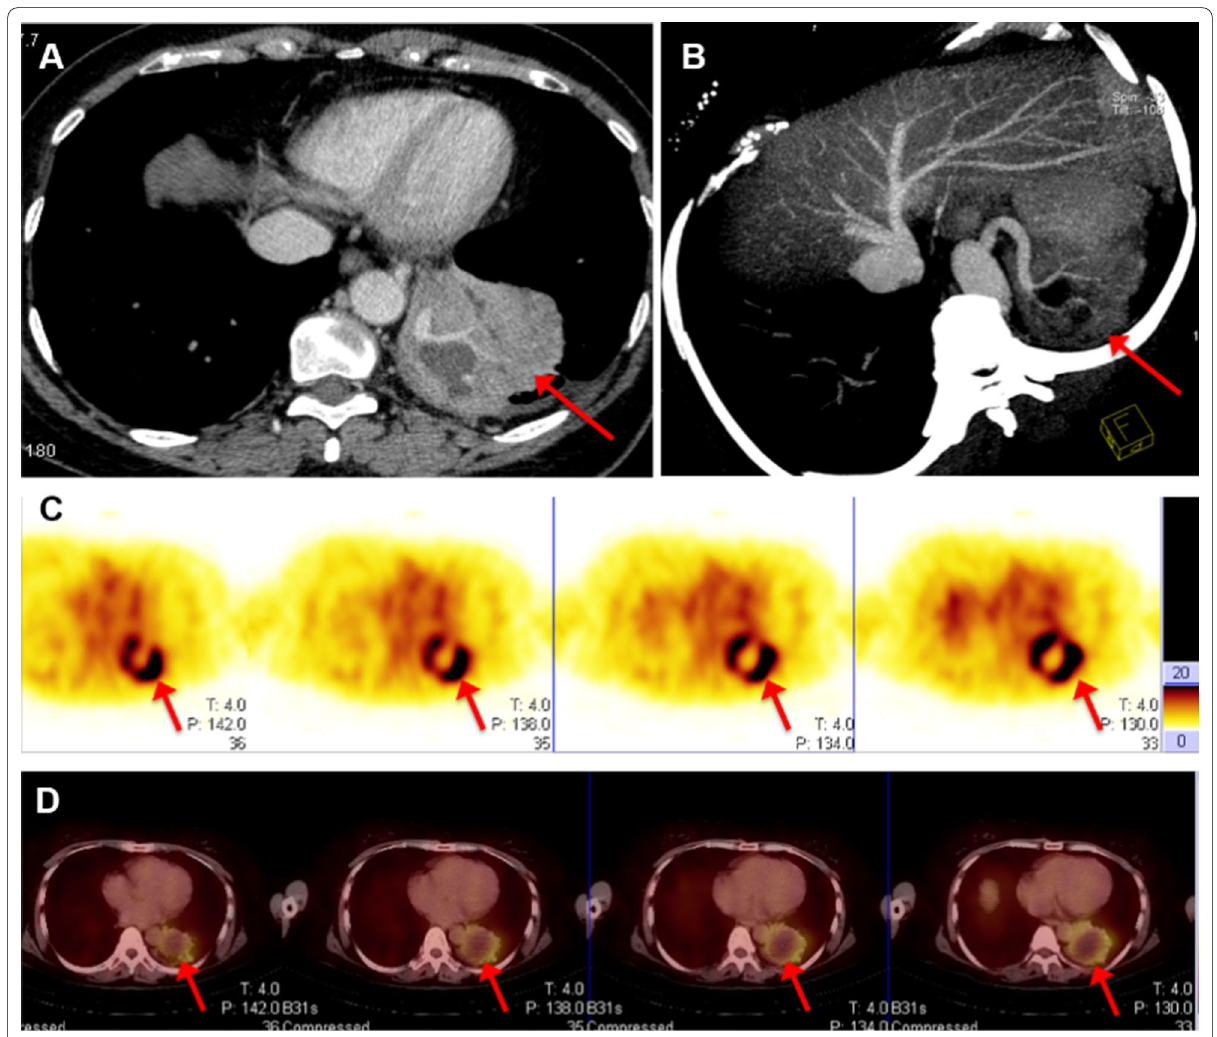
Fig. 4 [ 99m Tc]Tc-Galacto-RGD 2 imaging showed focal uptake in a patient with pulmonary sequestration. a , b Enhanced CT showed the tumour blood supply originated from the abdominal aorta. c , d RGD imaging showed focal uptake in the tissue, and necrosis in the central zone of the